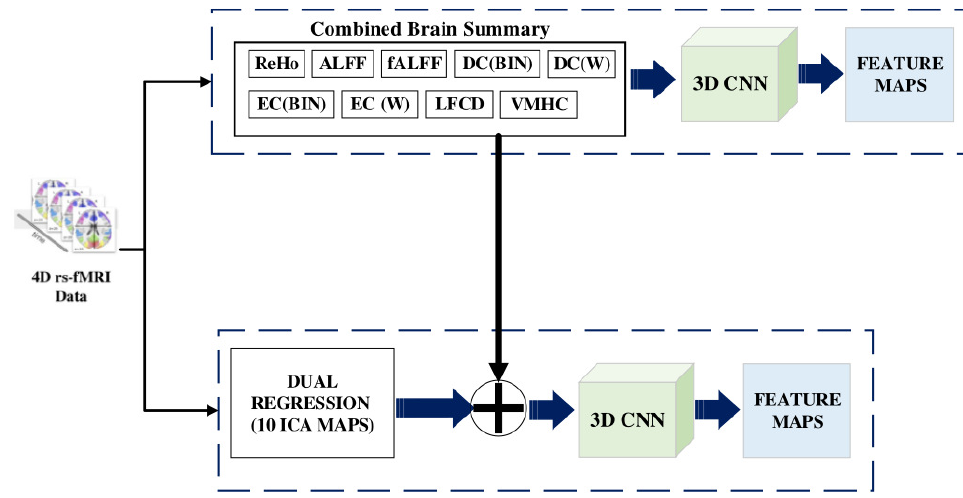
Figure 5. Feature Selection from rs-fMRI